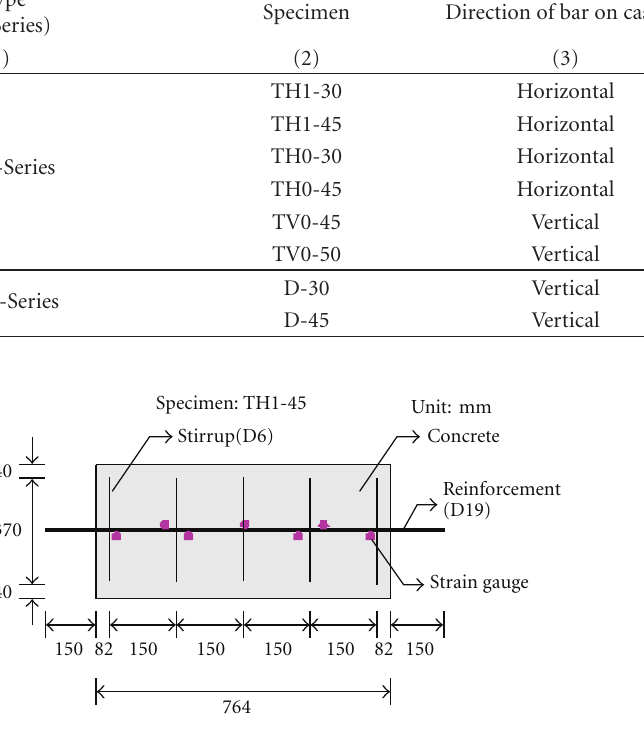
Figure 8: Sectional properties of the specimen TH1-45 and positions of strain gauges.